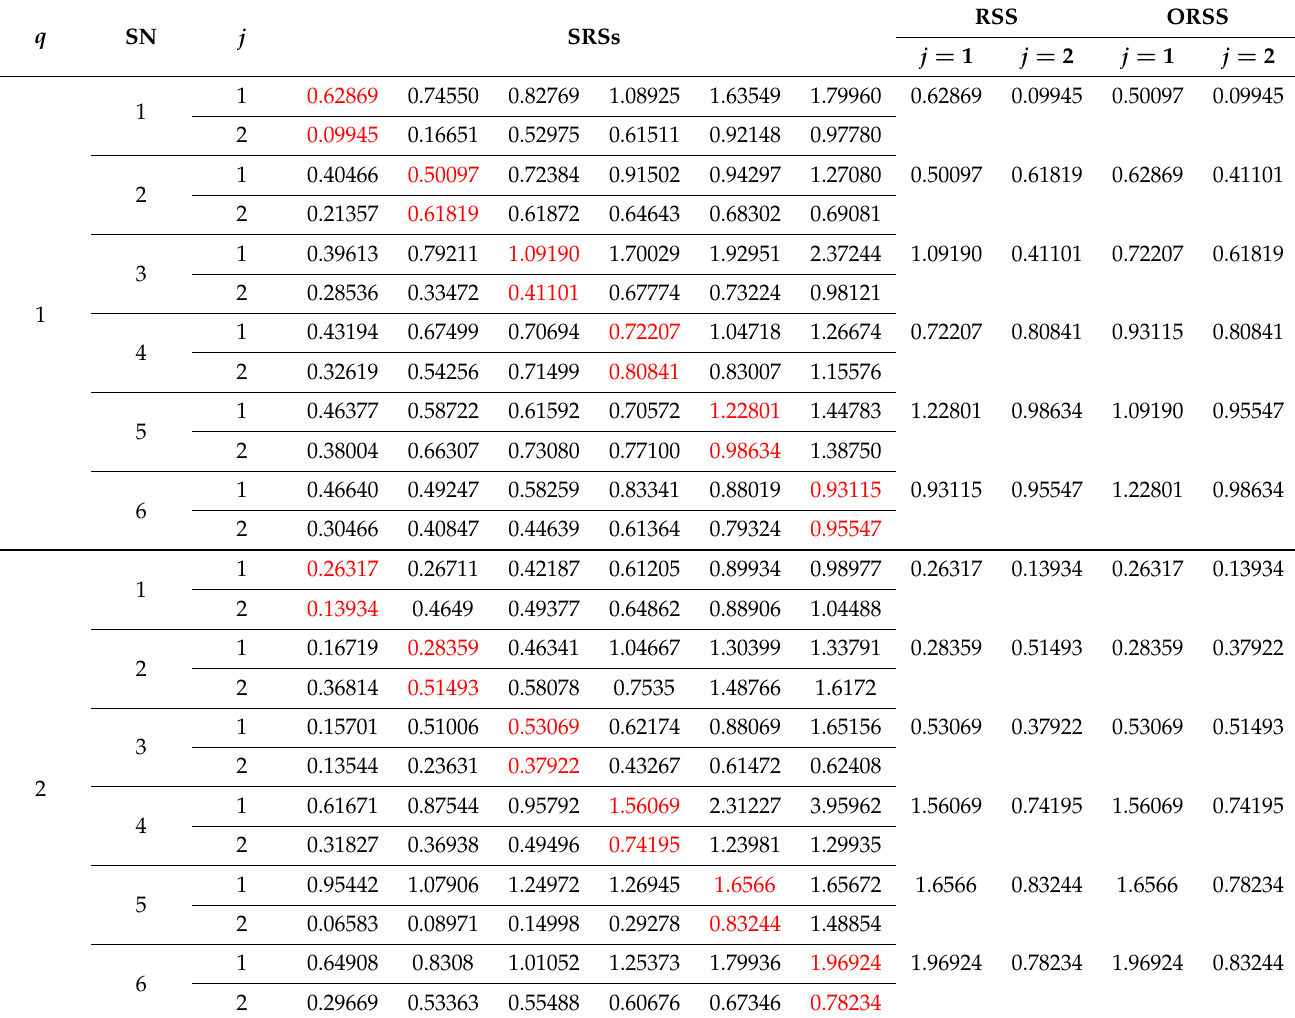
Table 1. The generated SRSs, RSSs, and ORSSs (one-cycle and